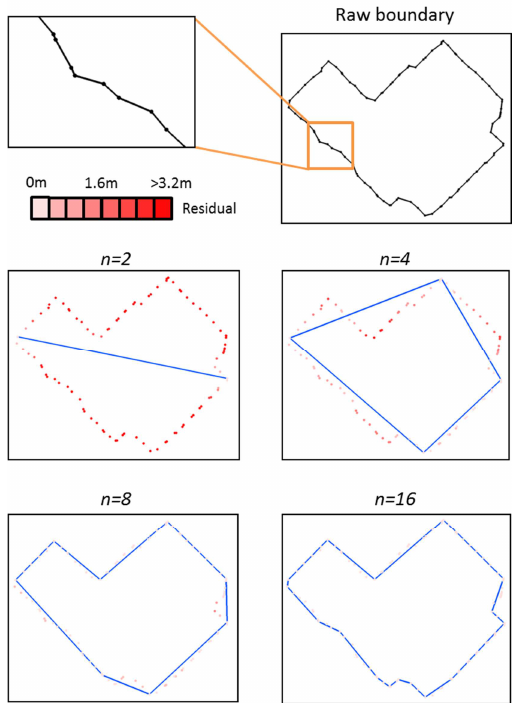
Figure 2. Polygonal hypotheses with different numbers of vertices.